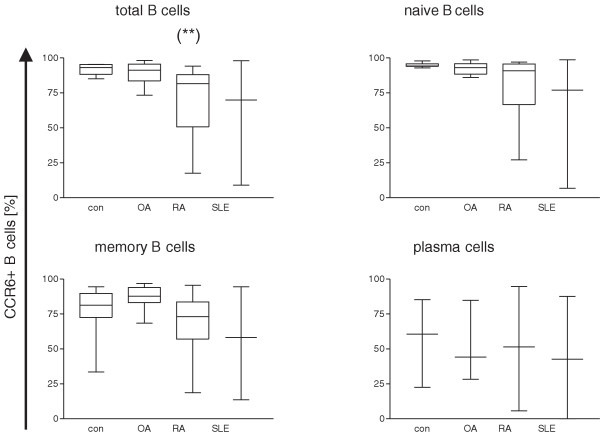
Chemokine receptor CCR6+ expression on B cell subpopulations. The percentage of total B cells, naive B cells, memory B cells and plasma cells expressing CCR6+ are given. Box plots show the median values, 25th and 75th quartile and the range of values. Significant differences from controls are shown (**P < 0.005).